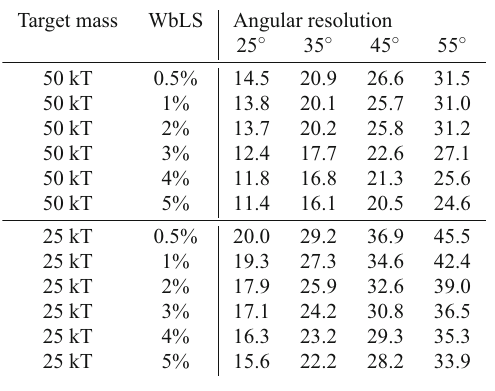
Table 7 CNO flux sensitivity (%) as a function of target mass, WbLS % and angular resolution for 5 years of data and 90% PMT coverage